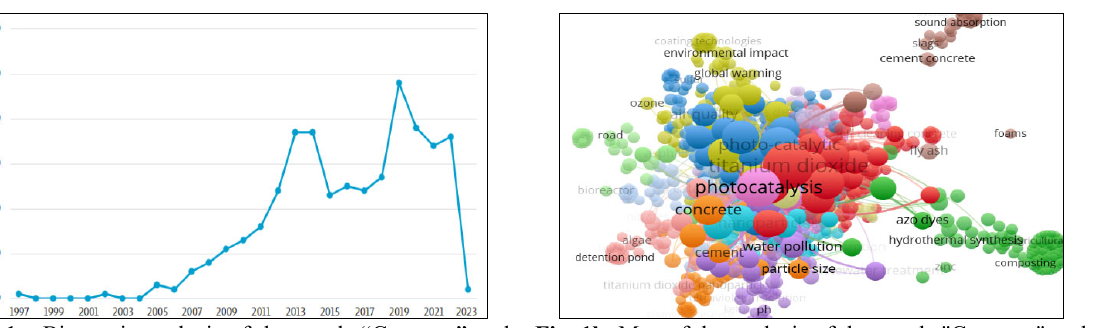
Fig. 1b. Map of the analysis of the words "Concrete" and "Photocatalytic" with the highest interaction Source: Ob- tained from VOSviewer